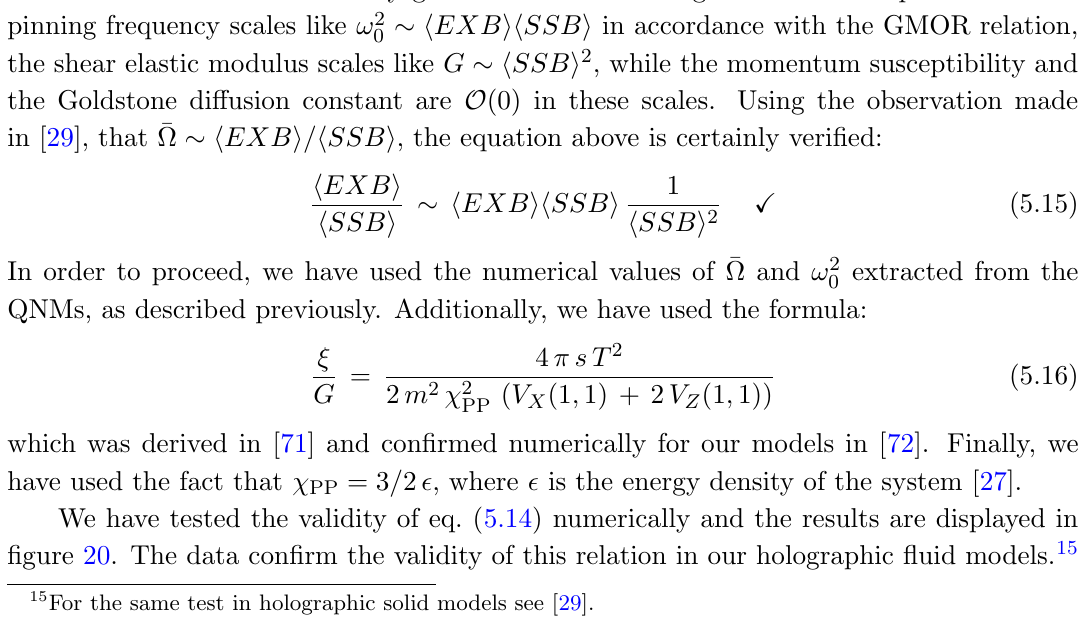
Figure 20 . The novel phase relaxation scale in the (cid:13)uid model V ( X; Z ) = (cid:11) f Z + (cid:12) f Z 2 . We (cid:12)x m=T = 0 : 3 ; (cid:11) f = 0 : 05 and dial (cid:12) f . This is a successful numerical check of the relation (5.14). The validity of this relation has been tested for more values of the free coe(cid:14)cients of the model. This relation can be directly guessed from the scaling of the various quantities.